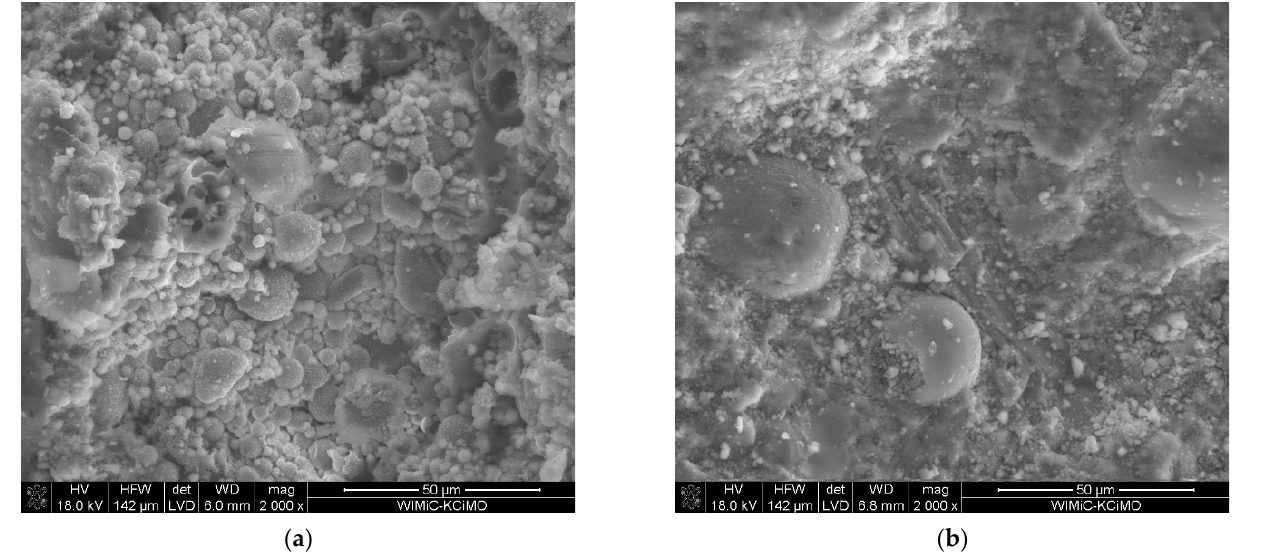
Figure 3. SEM micrographs of the 60PC-20GBFS-15SFA cement paste after ( a ) 2 days and ( b ) 28 days.